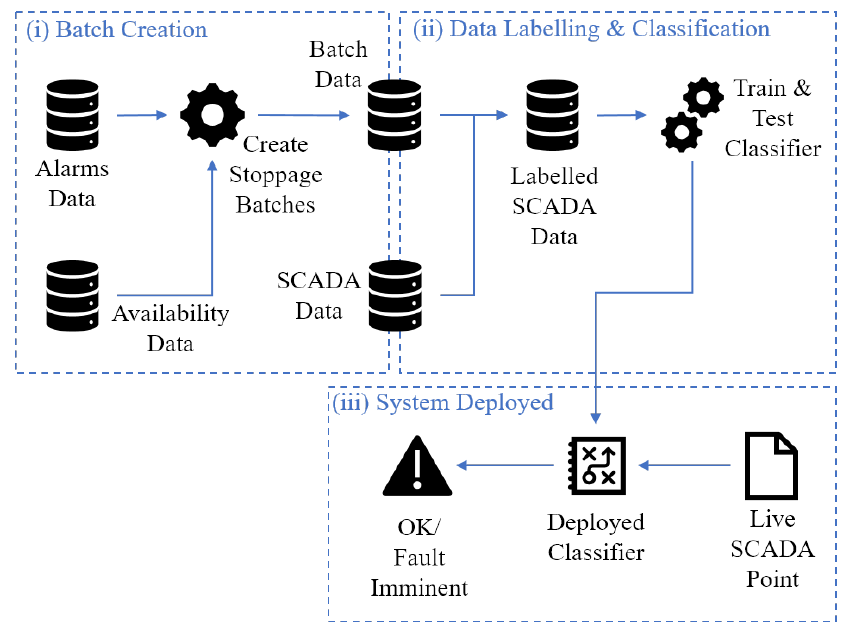
Figure 1. Overview of overall